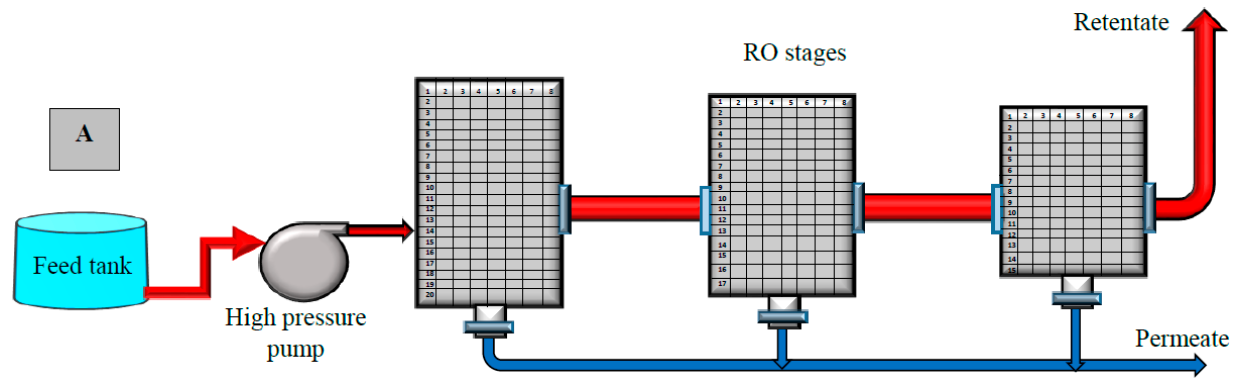
Figure 4. A schematic diagram of a conventional RO desalination plant (Adapted from [2]).